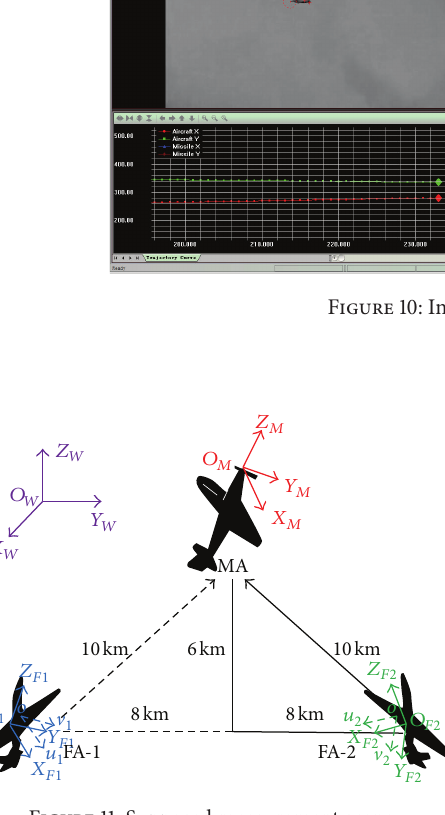
Figure 11: Supposed measurement